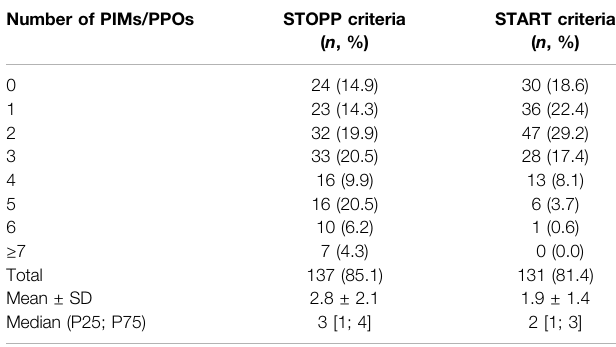
TABLE 4 | Number of potentially inappropriate medications (PIMs) and potential prescribing omissions (PPOs), according to Screening Tool of Older People ’ s Prescriptions (STOPP) and Screening Tool to Alert to Right Treatment (START) criteria, respectively ( N (cid:1) 161). Number of PIMs/PPOs STOPP criteria START criteria ( n , %) ( n ,